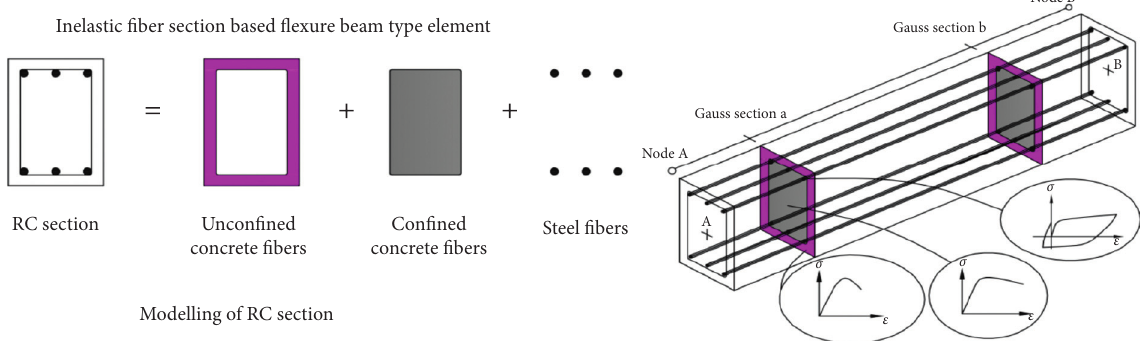
Figure 11: Idealization of beams and columns members, FE based frame element’s inelastic modelling.